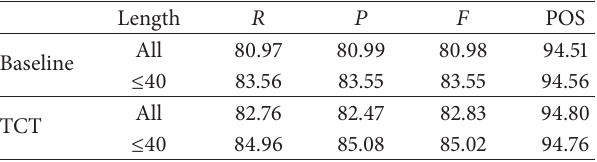
Table 5: POS and parsing accuracy on TCT in character-based